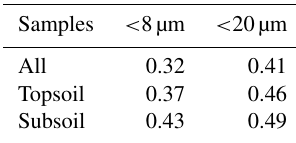
Table A1. Correlation coefficient between SOC and particle size data < 8 and < 20µm for all samples ( n = 1601), topsoil (0–20cm; n = 791) and subsoil (20–50cm; n =